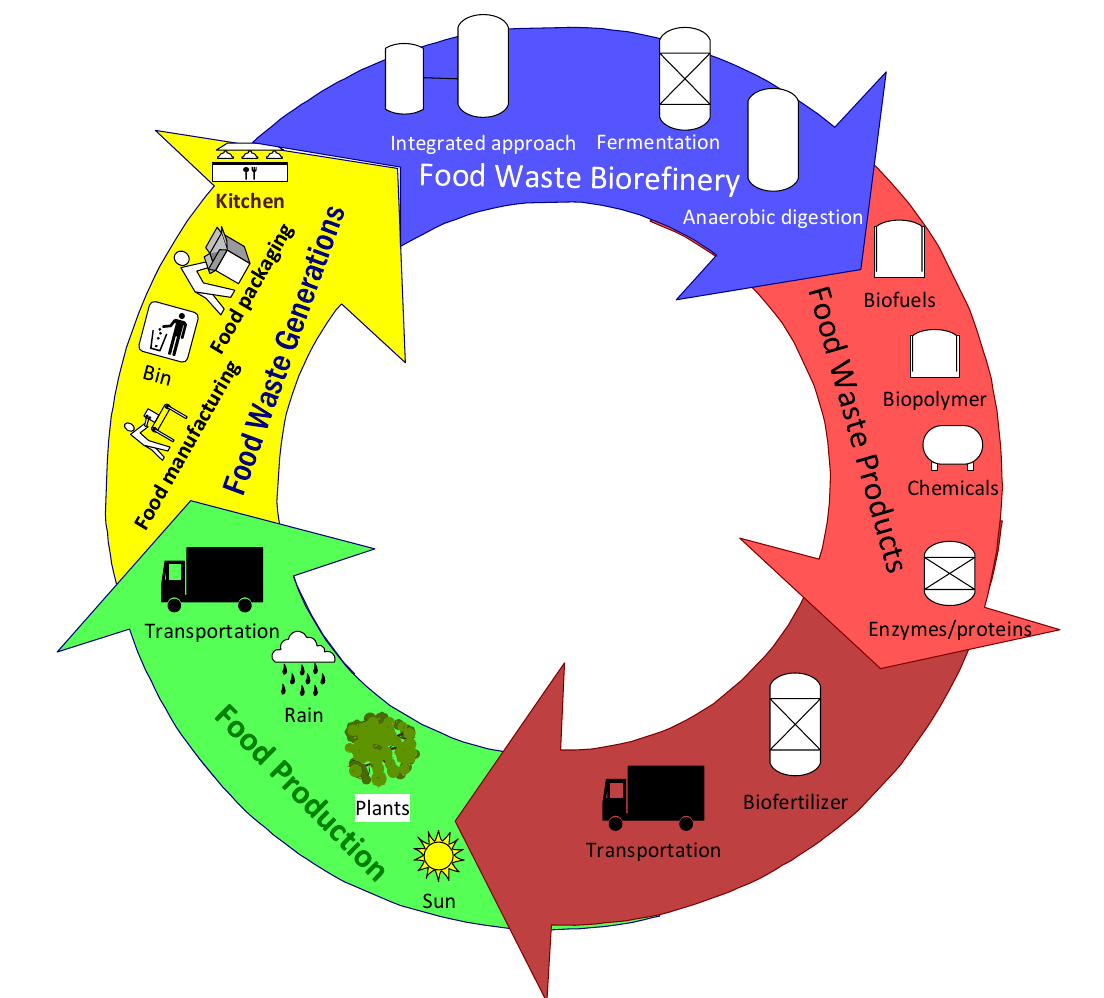
Figure 1. The prospect of circular bioeconomy in food industries.